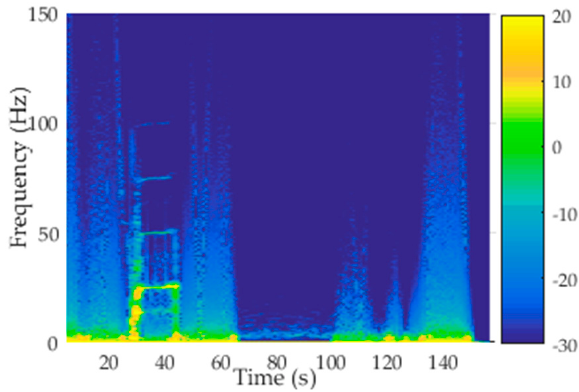
Figure 21. Fourier transform (STFT) of TM speed without control.